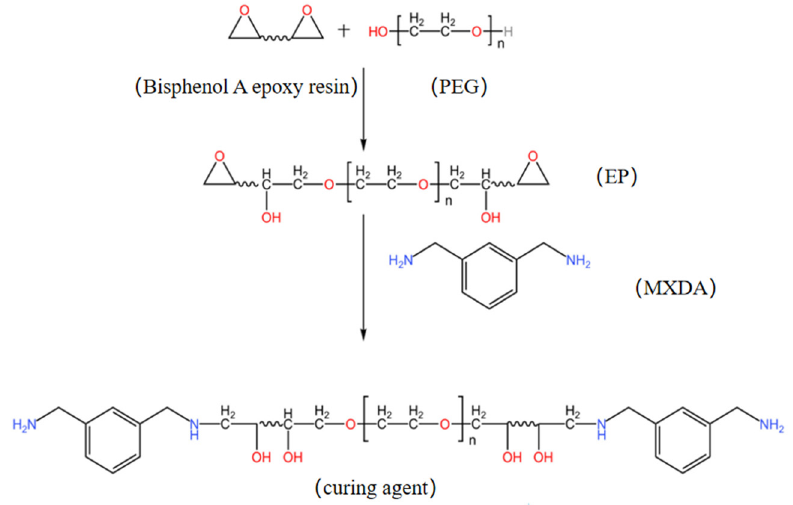
Figure 2. Synthesis route of a self ‐ emulsifying non ‐ ionic waterborne epoxy curing agent.